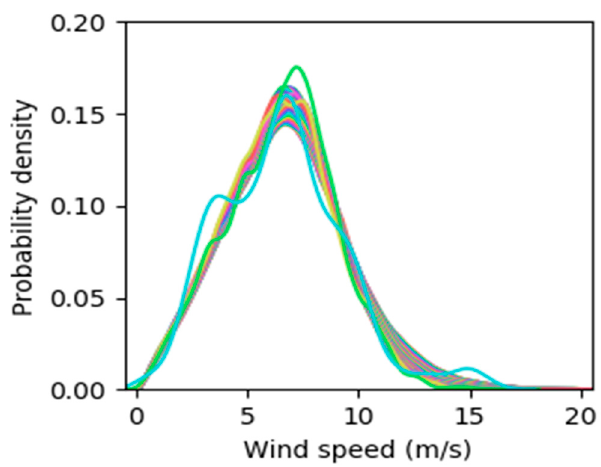
Figure 3. Distribution of P wind as a function of incidence angle (unlabeled colored lines indicate the probability density distribution of wind speed at each incident angle bins).